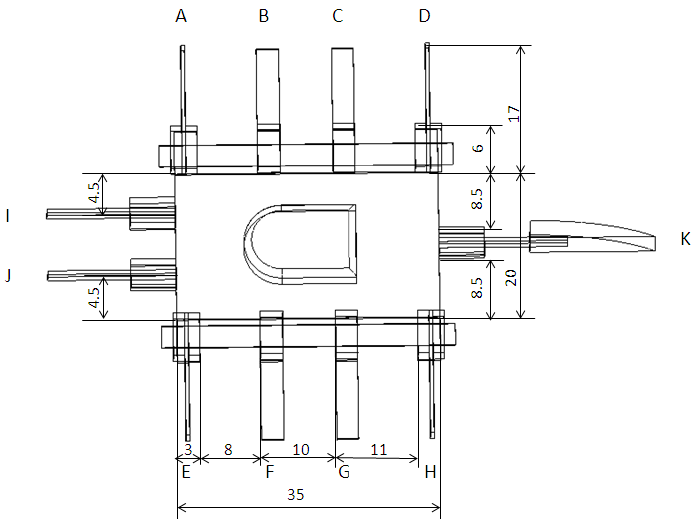
Figure 14. Leg sequence and dimensions of the proposed